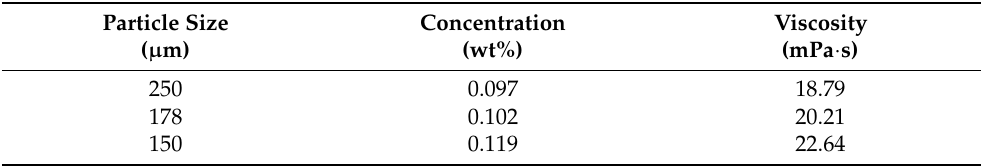
Table 5. The viscosity of CNMs suspensions with different particle sizes.